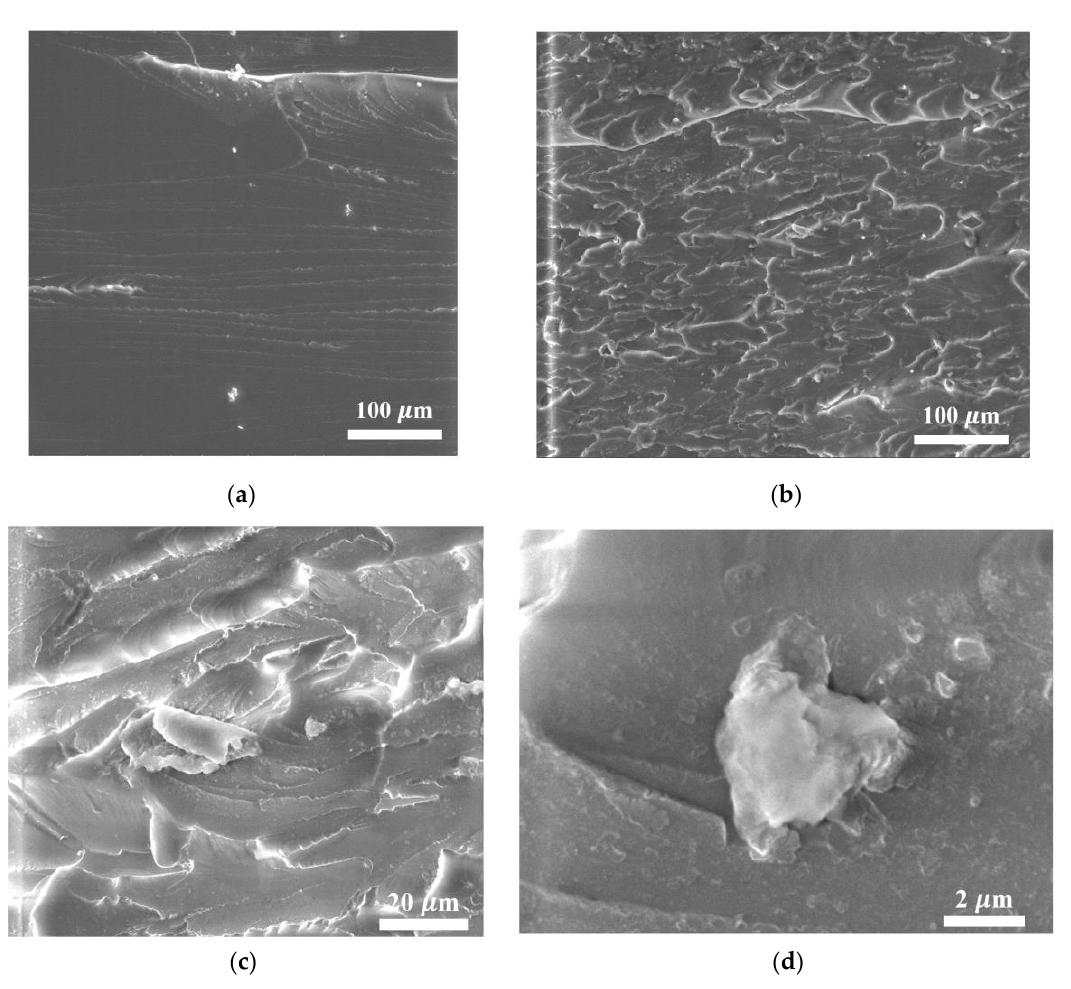
Figure 5. SEM images of ( a ) cleavage sample (fractured surfaces) from the original resin (linear scale 100 µm); ( b ) modified 1 wt. % FLG (linear scale 100 µm); ( c ) modified 1 wt. % FLG (linear 100 µ m); ( b ) modified 1 wt. % FLG (linear scale 100 µ m); ( c ) modified 1 wt. % FLG (linear scale scale 20 µm); and ( d ) modified 1 wt. % FLG (linear scale 2 µm). 20 µ m); and ( d ) modified 1 wt. % FLG (linear scale 2 µ